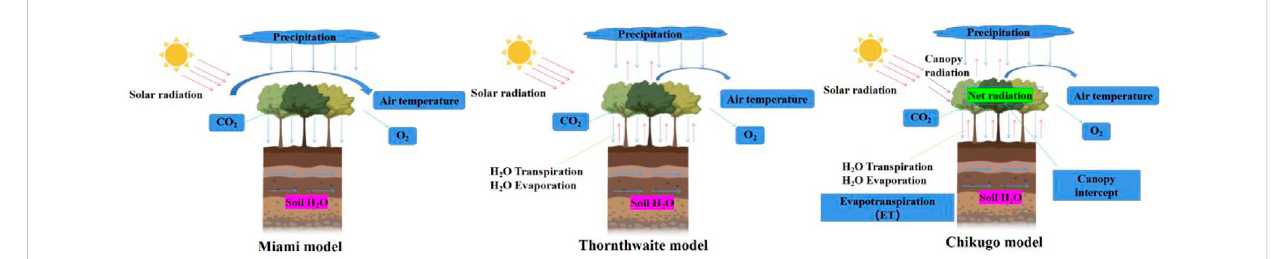
FIGURE 1 Schematic simulation process of typical statistical models.